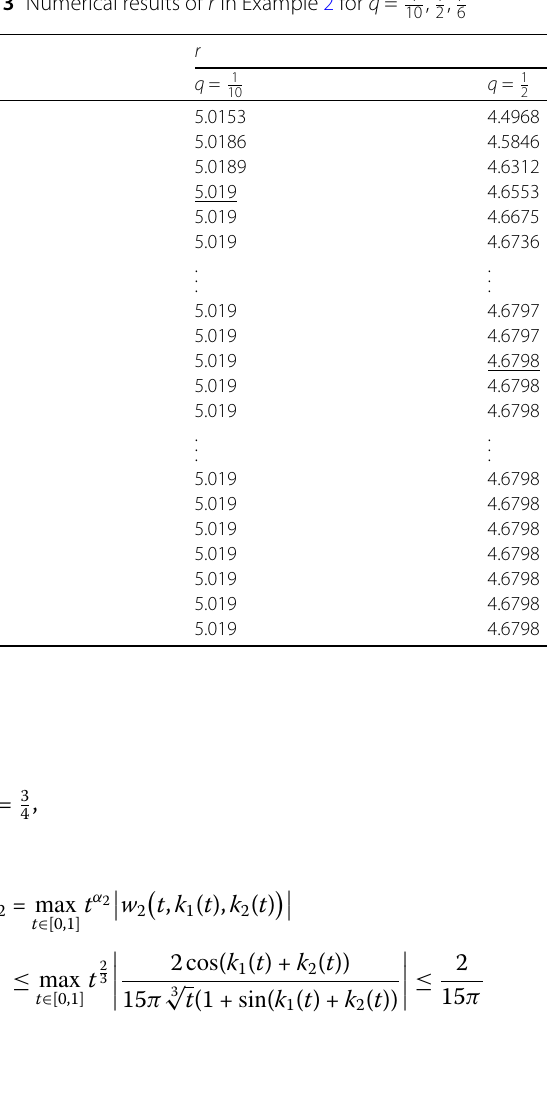
Table 13 Numerical results of r in Example 2 for q = 1